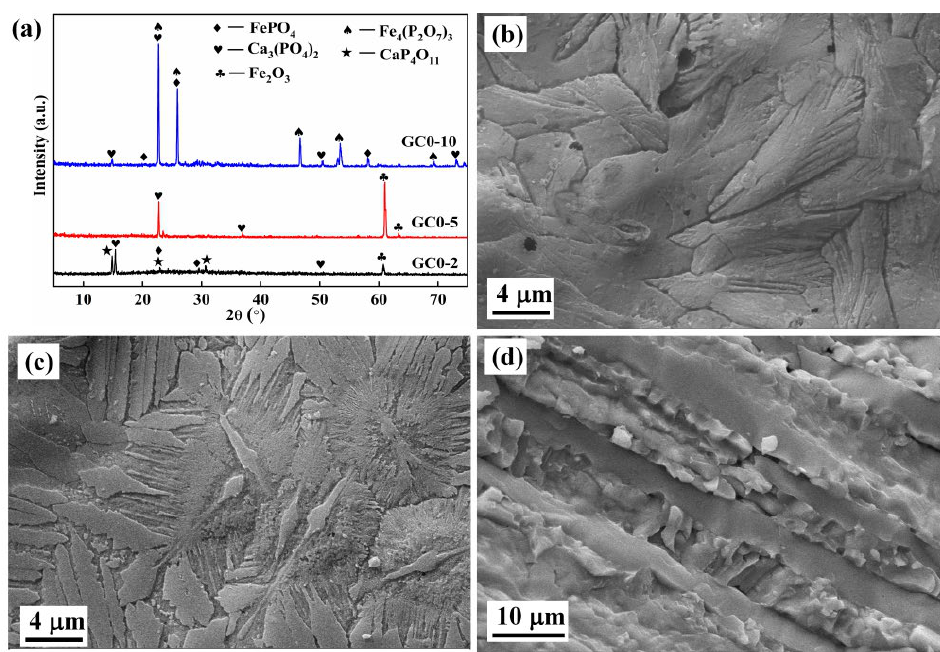
Figure 5. ( a ) The XRD patterns of the GC0 bulk sample at different crystallization times of 2 h (GC0-2), 5 h (GC0-5), and 10 h (GC0-10). SEM images of the surface of the GC0 sample at different crystallization times of ( b ) 2 h, ( c ) 5 h, and ( d ) 10 h after 40% HF etching for 15~20 s.